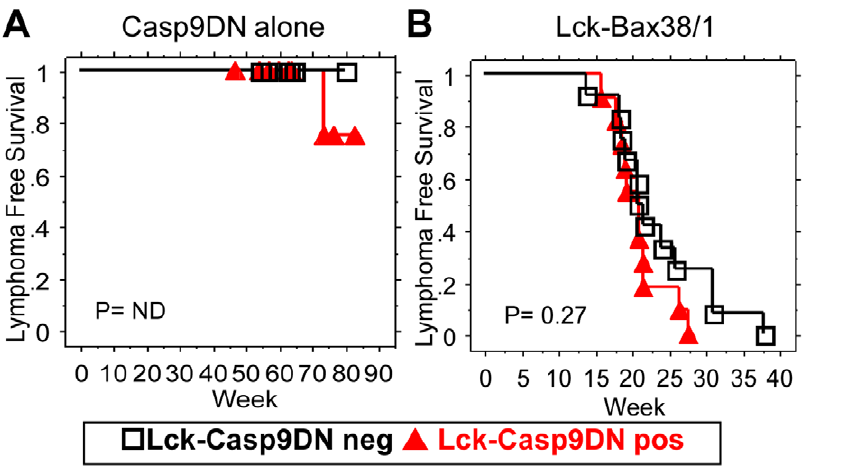
Figure 5. Casp9DN expression does not promote lymphoma formation in Lck-Bax38/1 transgenic mice. Kaplan-Meier analysis for lymphoma free survival A ) comparing wild type (black open square, N=8) and Lck-Casp9DN (green solid triangle, N=12) mice, and B ) comparing Lck-Bax38/1 (black open square, N=12) and Lck-Casp9DN x Lck-Bax38/1 (red solid triangle, N=11) mice. Those mice were followed for lymphoma- free survival as described under materials and methods. P-value of analysis is shown. ND=not determinable without any events in the control group.